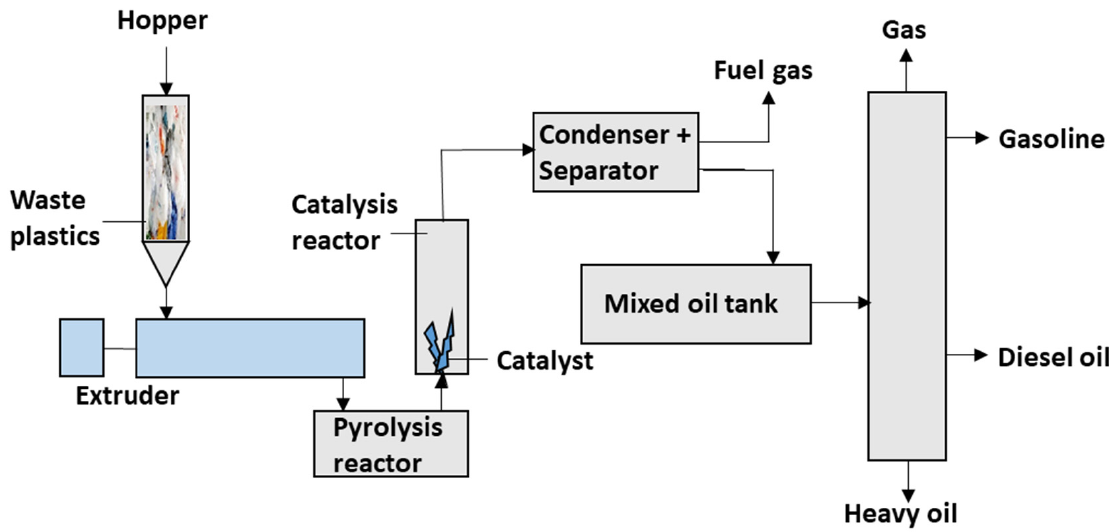
Figure 3. Catalytic pyrolysis upgrade technique for fuel separation (adapted from [58]).